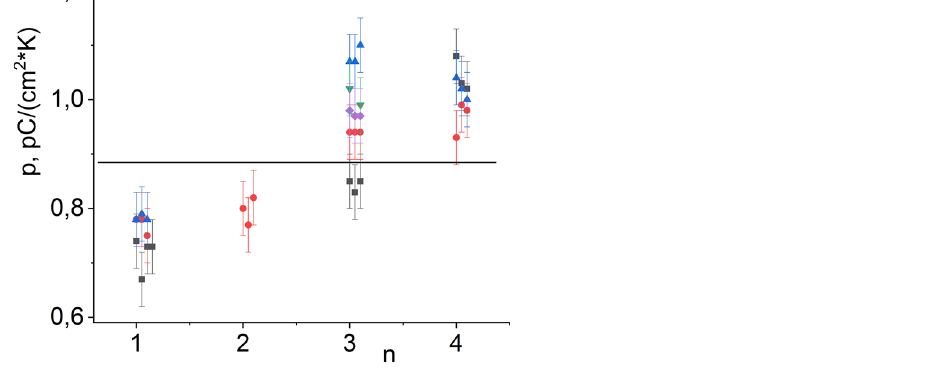
Figure 10. The values of the pyroelectric coefficient measured for samples of different series of the hot-pressed Bi 3 TiNbO 9 ceramics (the horizontal line indicates the average pyroelectric coefficient p σ = 0.88 nC/(cm 2 ·K) for all measurements). Sample modifications: (1) an intact Bi 3 TiNbO 9 powder (2) Bi 3 TiNbO 9 powder treated with 36.7% ethyl alcohol; (3) Bi 3 TiNbO 9 powder treated with Bi 3 TiNbO 9 UHDs; (4) Bi 3 TiNbO 9 powder treated with lactose